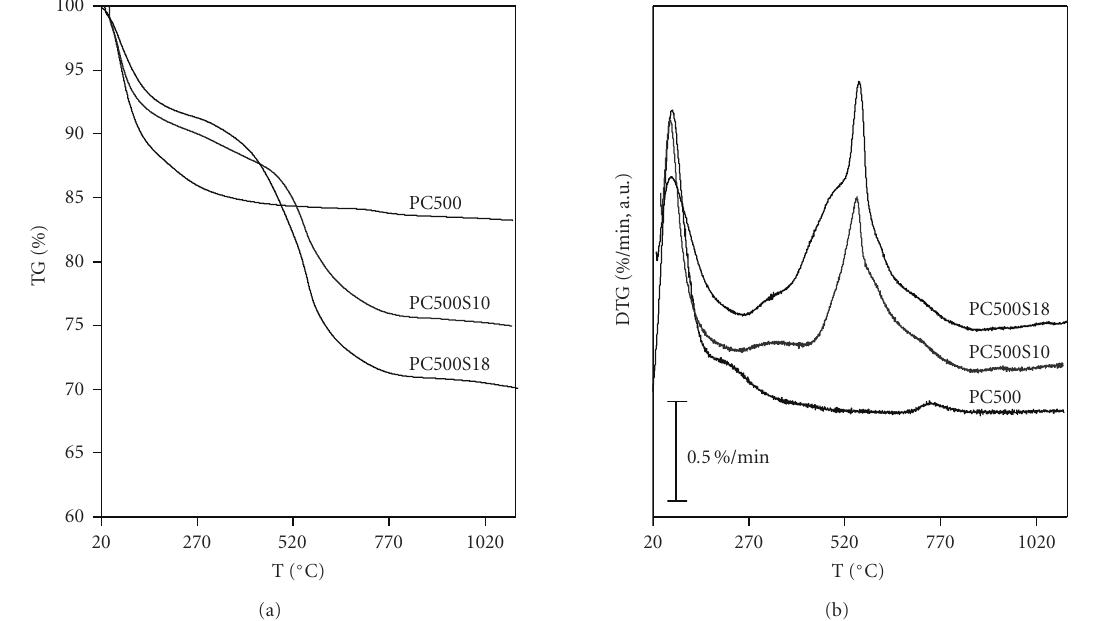
Figure 1: TG (a) and DTG (b) curves of PC500, PC500S10, and PC500S18